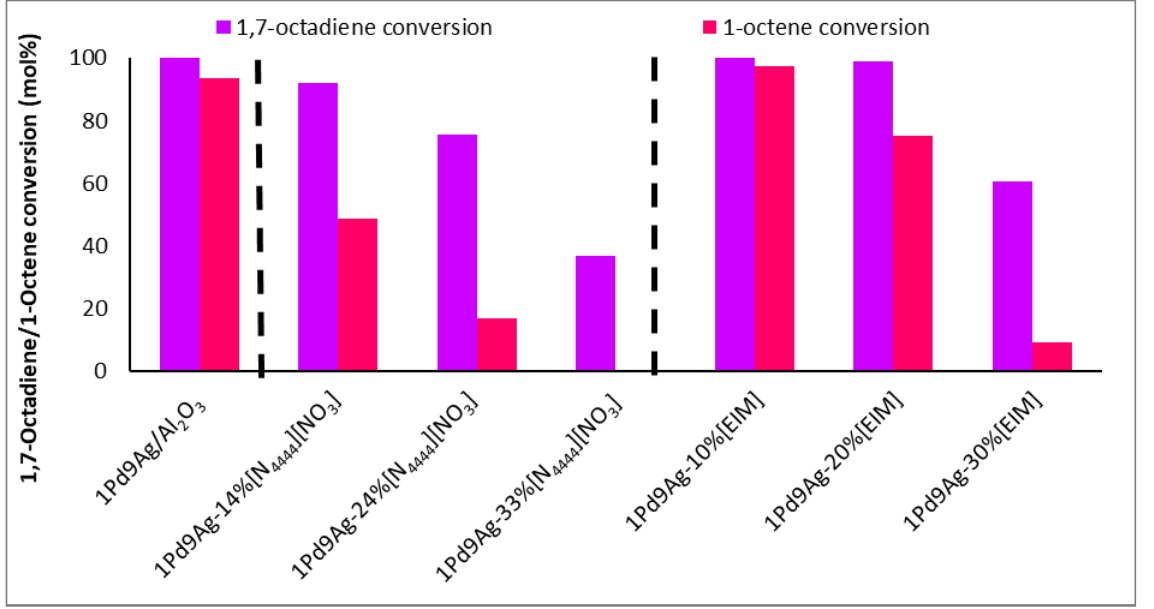
Figure 1. Conversion of 1,7-octadiene and 1-octene over 1Pd9Ag-14%[N 4444 ][NO 3 ]. Reaction condi- tions: Temperature: 100 °C, Pressure: 30 bar, Diene:H 2 ratio: 1:3.5, LHSV: 9 h −1 , Feed: 2 wt% 1,7 oc- tadiene, 10 wt% octene in hexane.